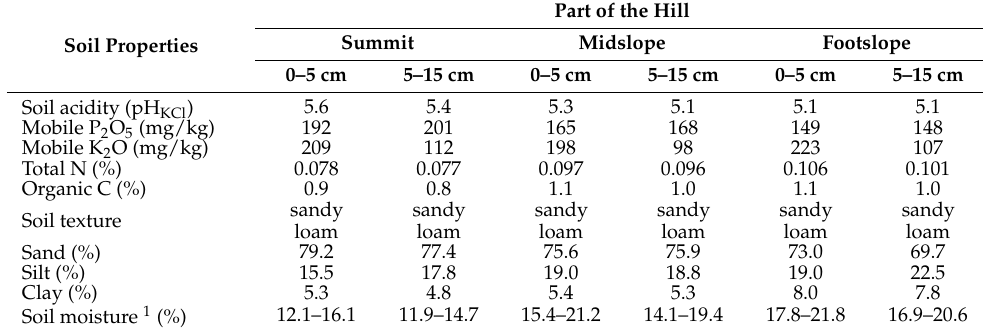
Table 2. Agrochemical and physical properties of the arable (0–15 cm) soil layer